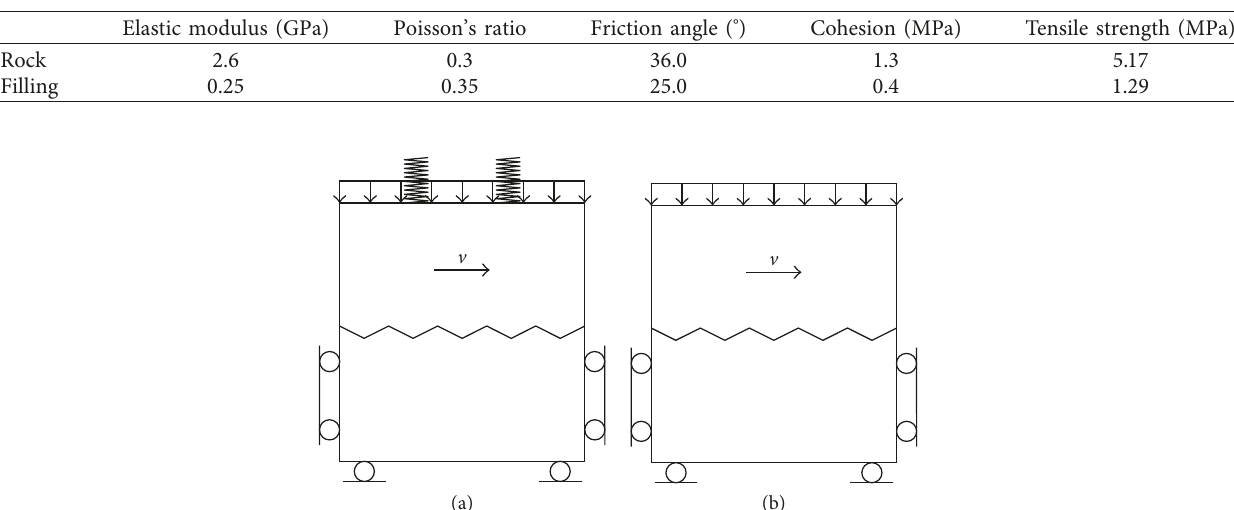
Table 1: Mechanical parameters of infilled joints.